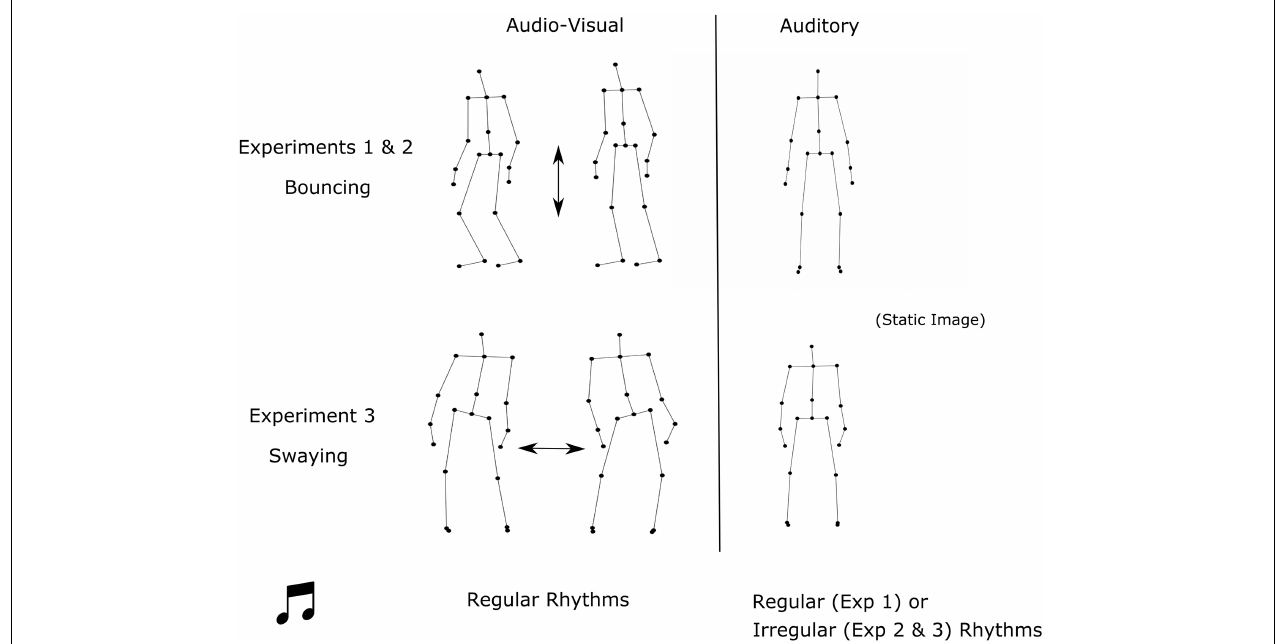
FIGURE 1 | Diagram showing the audio-visual (AV) and auditory conditions for the rhythmic priming experiments. The AV condition in Experiments 1 and 2 consisted of a bouncing figure that bounced up and down in time with the music. In Experiment 3 the AV condition consisted of a swaying figure that swayed side to side. The AV condition consisted of regular rhythms for all experiments, whereas the auditory condition consisted of regular rhythms in Experiment 1 and irregular rhythms in Experiments 2 and